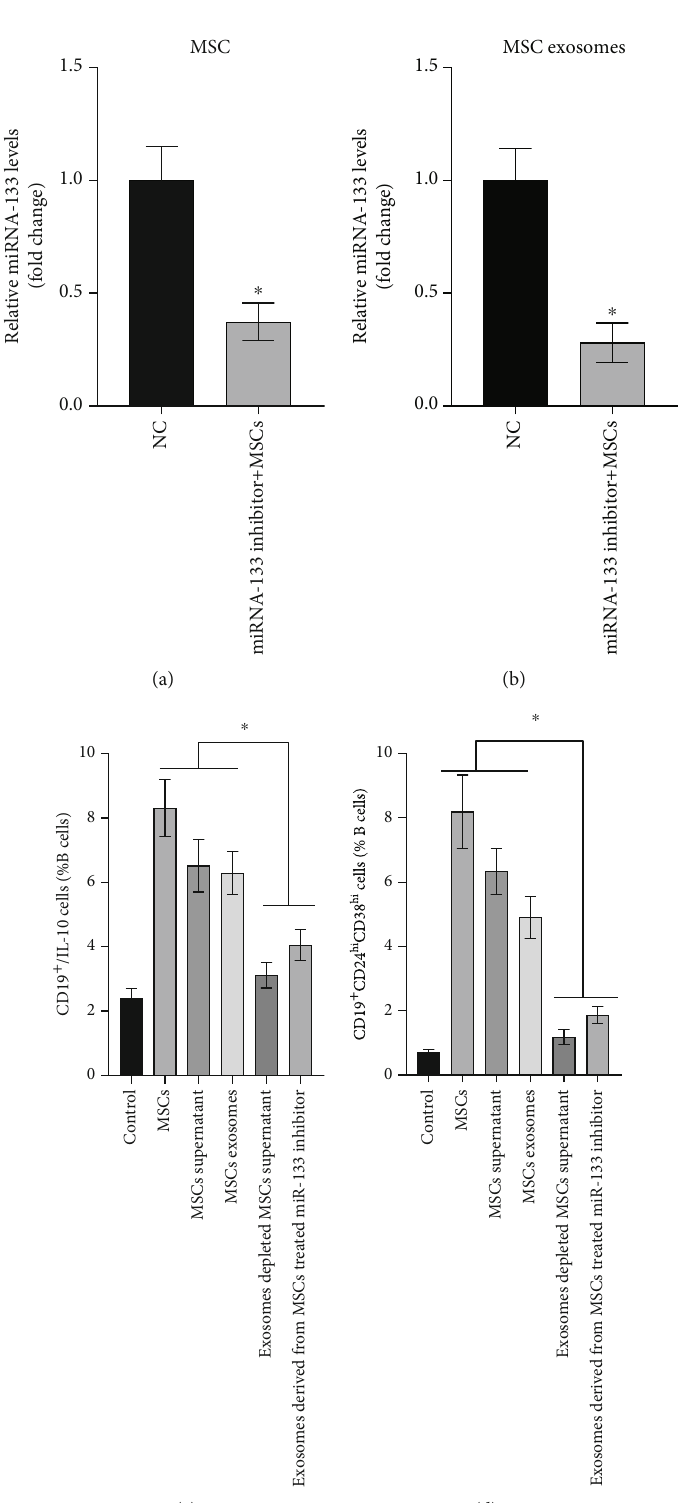
Figure 6: miR-133 mediates the e ff ects of MSCs on B cells dependent on exosome-based delivery. (a, b) Transfected with the miRNA-133 inhibitor, the miRNA-133 level was signi fi cantly depressed in MSCs or exosomes. (c, d) When PBMCs are cultured with the MSCs, MSC supernatant, or MSC exosomes, the percentage of CD19 + CD24 hi CD38 hi CD19 + B cells and IL-10-producing CD19 + B cells will increase, but this phenomenon was reversed when the MSCs were pretreated with the miRNA-133 inhibitor or the MSC supernatants were depleted of exosomes. ∗ P < 0 : 05